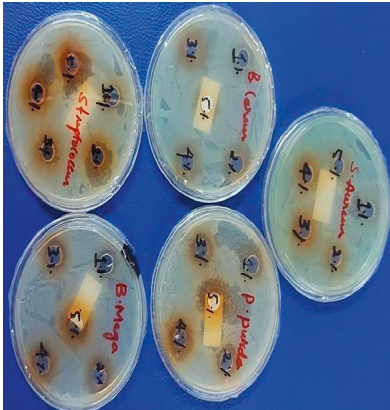
Figure 9: Zone of inhibition of ethanolic extract by agar diffusion